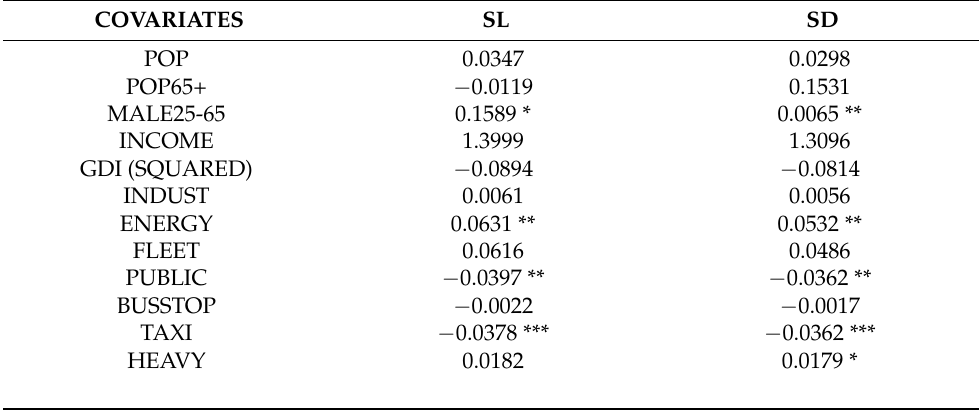
Table A4. Indirect Impacts: SL- and SD- PD-STIRPAT model (Random